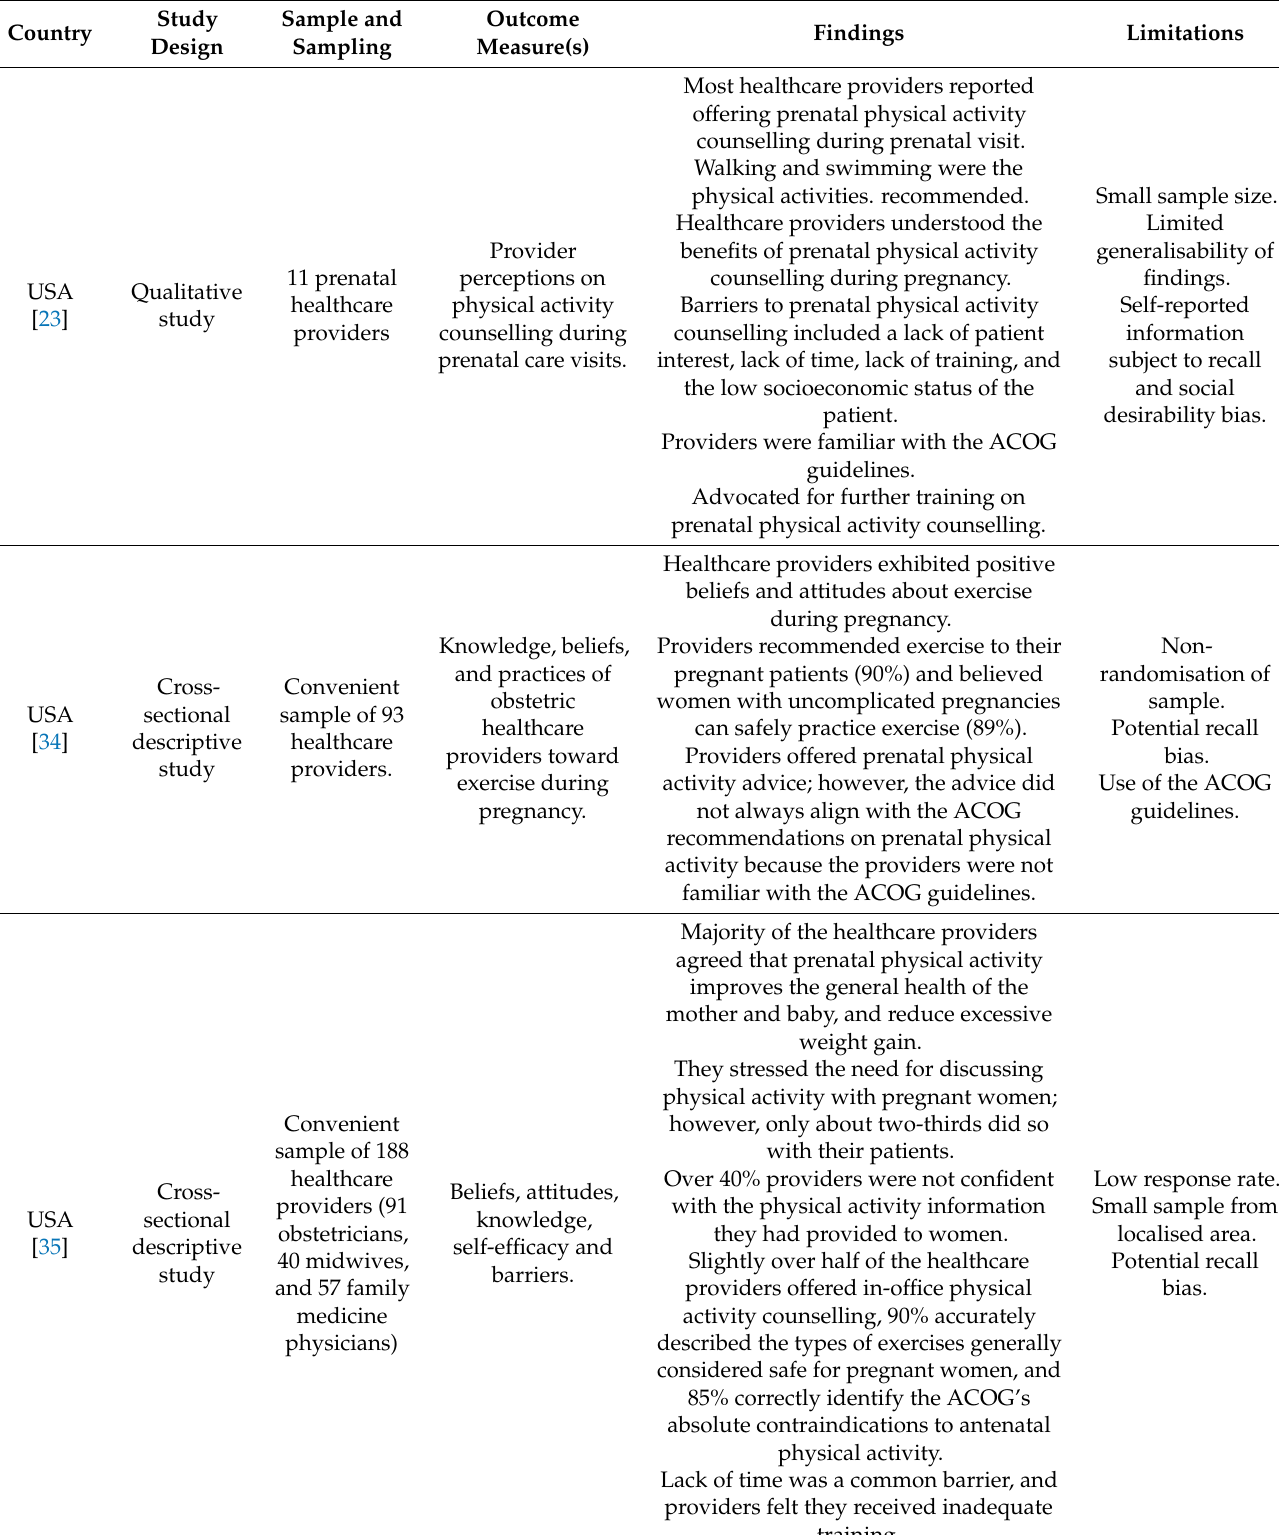
Table 1. Summary of articles on knowledge, attitude and practices of prenatal care health providers regarding prenatal physical activity